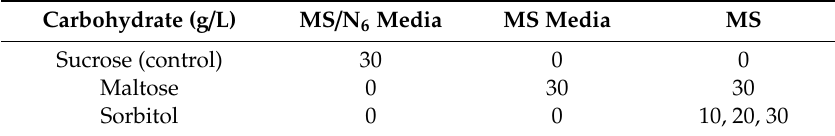
Table 5. The carbohydrate concentration used in callus